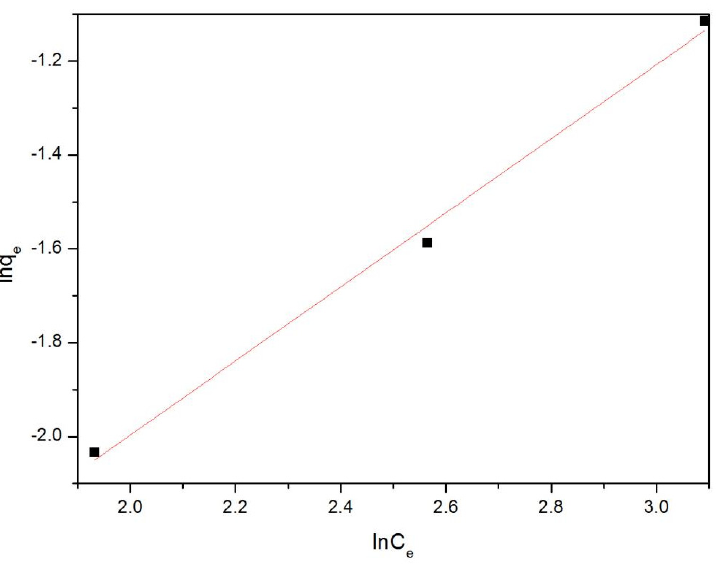
Figure 8. Freundlich isotherm for the adsorption of CR on Fe-MOFs (50 mg, 50 ppm, 20 ° C).